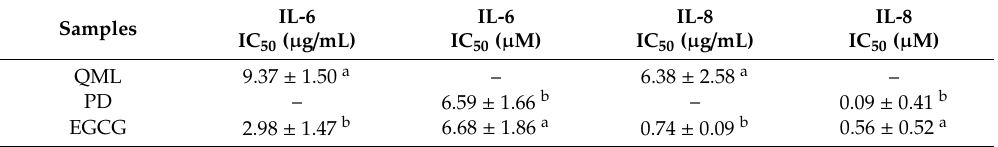
Table 2. IC 50 values of QML and PD against inhibitory activity on IL-6, IL-8 production.